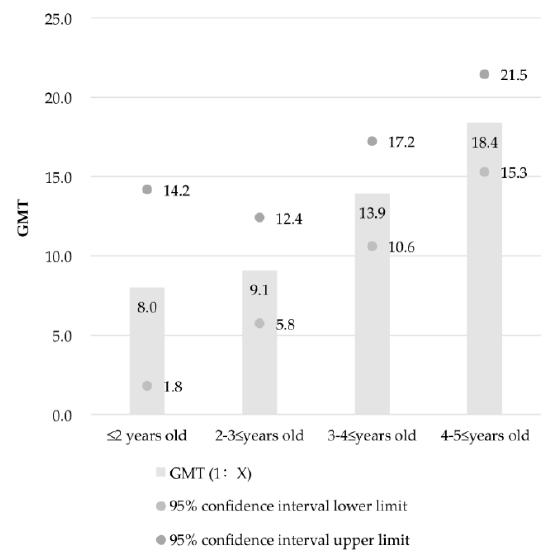
Figure 3. Geometric mean titre (GMT) and GMT 95% confidence intervals of EV71 neutralizing antibodies in different age groups of children.